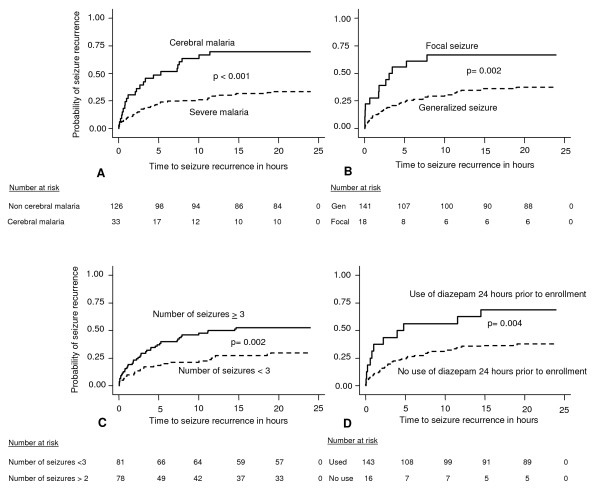
Kaplan-Meier plots of time to first seizure recurrence within 24 hours after initial control for the subgroups indicated. Figure 2 shows Kaplan Meier survival plots showing time to seizure recurrence within 24 hours after initial control of the seizure in the following subgroups of patients: A. Malaria type: Cerebral malaria vs. non-cerebral malaria. B. Seizure type: Focal seizures vs. generalized seizures. C. Seizure frequency *: > 2 vs. < 3. D. Prior treatment with diazepam*: Received diazepam vs. did not receive diazepam. * 24 hours prior to presentation to the acute care unit.